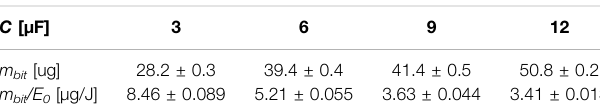
TABLE 5 | Ablation characteristics of propellant at different